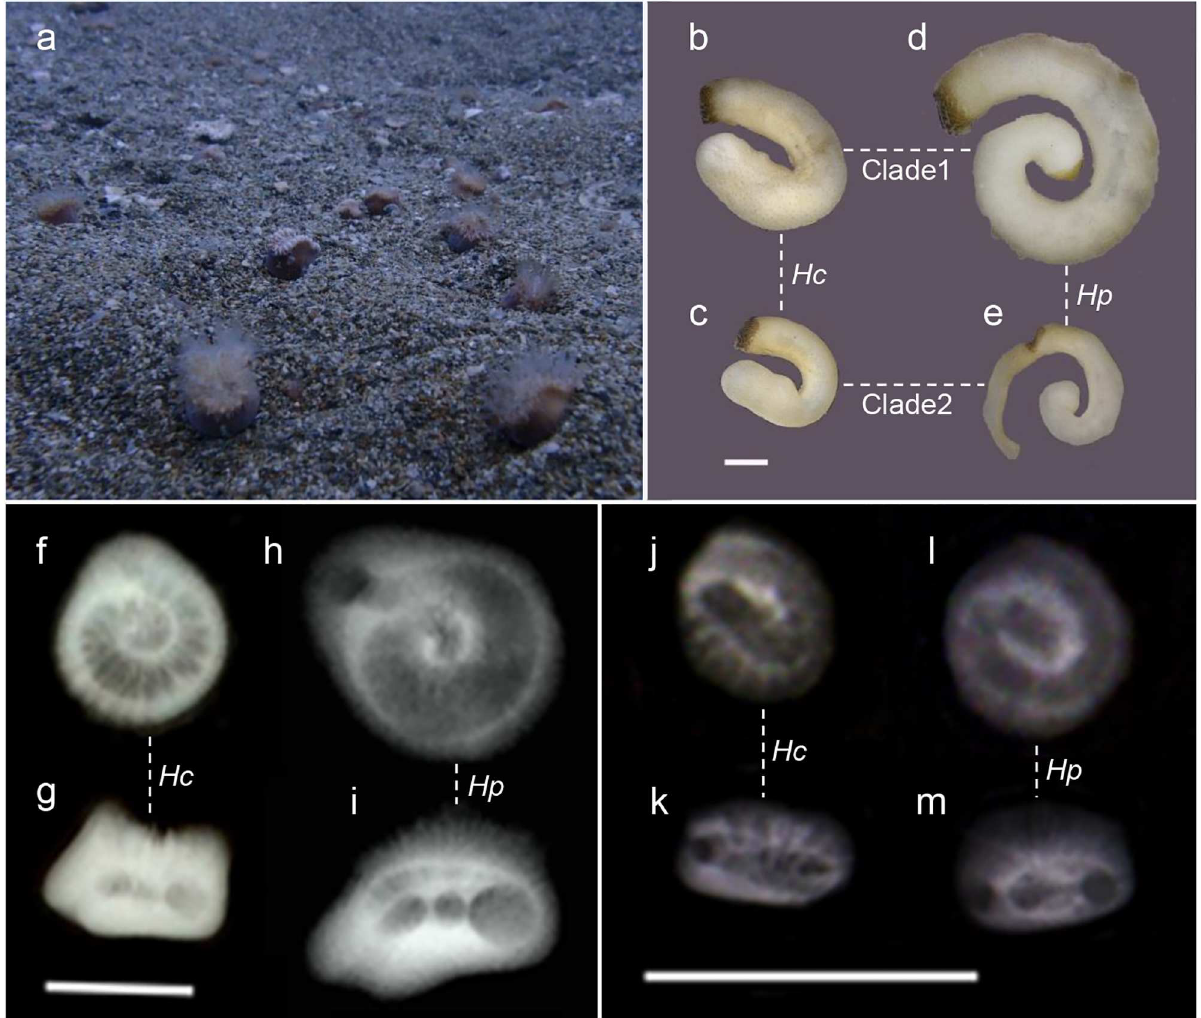
Fig 1. The habitat and specimens of studied walking corals and their symbiotic sipunulans. a, A densepopulationof walkingcorals on the sandy bottom of Kin Bay; b–e, Photographs of ethanol-fixed sipunculans from clade 1 (b, d) and clade 2 (c, e) (scale bar = 1 mm), symbiotic with Heterocyathus aequicostatus (b–c) and Heteropsammia cochlea (d–e); f–m, Soft X-ray images of Heterocyathus aequicostatus (f–g, j–k) and Heteropsammia cochlea (h–i, l–m) of Kin Bay (scale bars = 1 cm), horizontal (f, h, j, l) and lateral (g, i, k, m) views of mature (f–i) and immature (j–m)